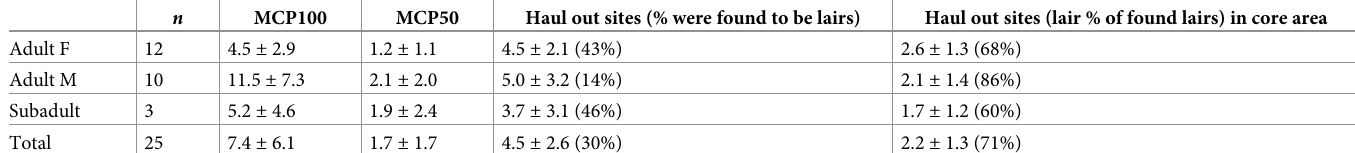
Table 2. Saimaa ringed seal winter season home ranges (mean ± SD, km 2 ), number of haul out sites, and the portion (%) of haul out sites confirmed to have lair structures. The data consist of 20 tagged seals, from which four had multiple interannual tracking periods, making the total n 25. n MCP100 MCP50 Haul out sites (% were found to be lairs)